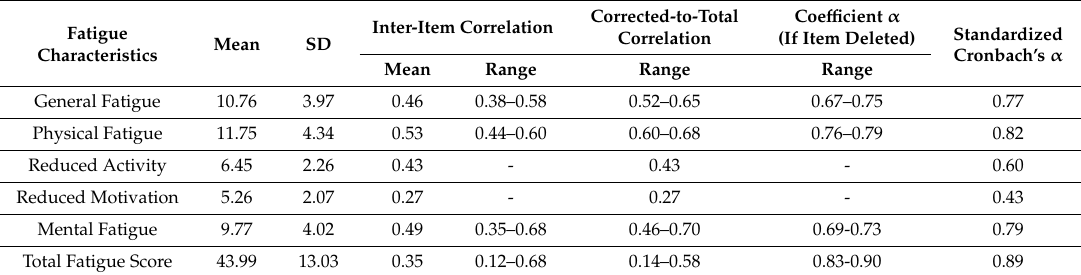
Table 6. Multidimensional Fatigue Inventory (MFI) 16-items characteristics and internal consistency